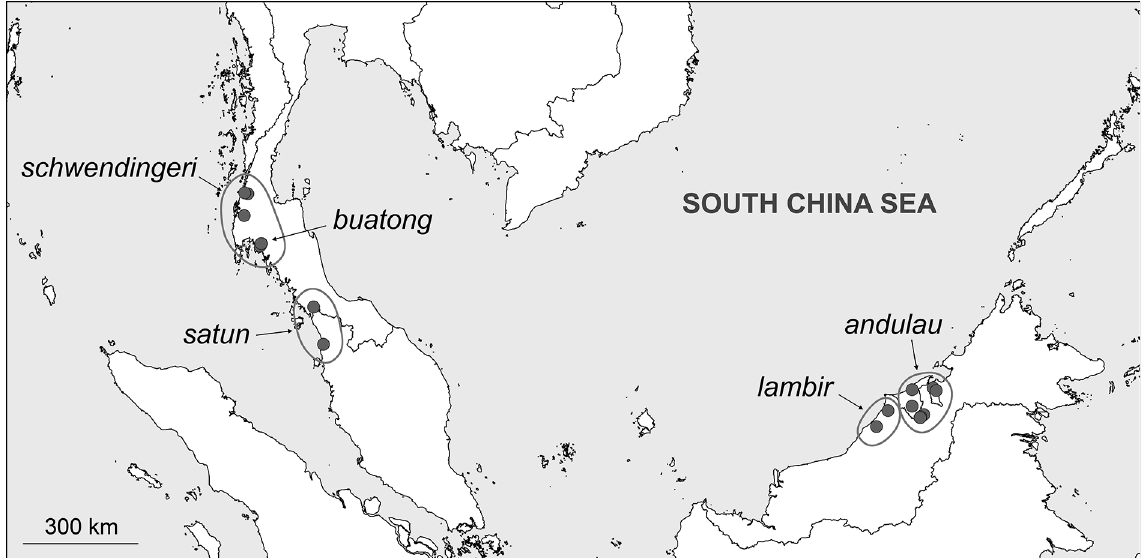
Fig. 153. Known distributions of the Pholcus buatong species group (Malay Peninsula) and of the Pholcus andulau species group (northern